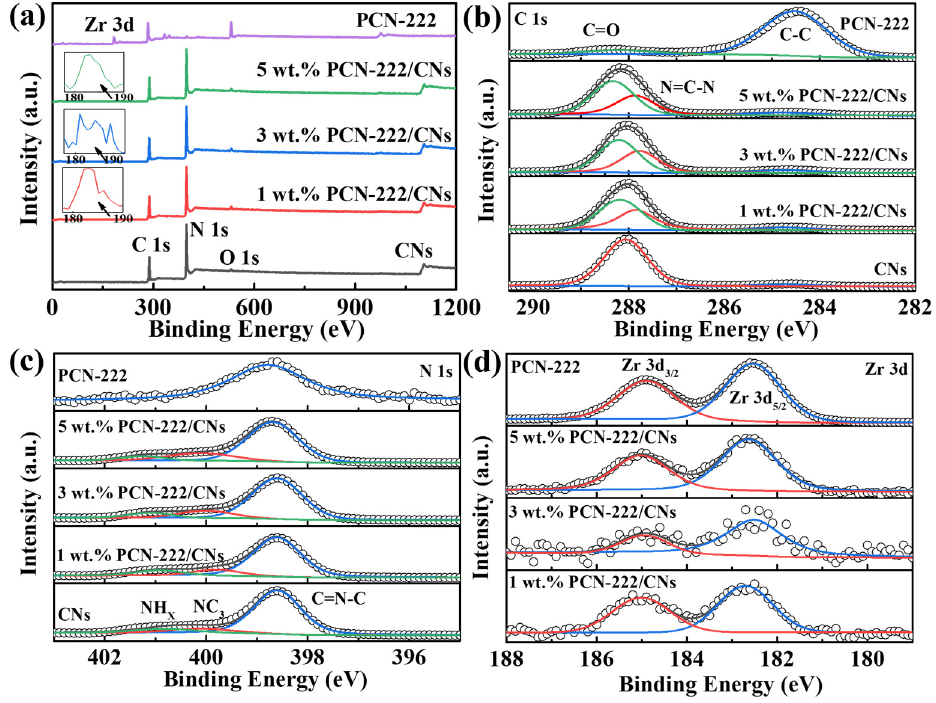
Figure 3. XPS spectra of PCN-222, CNs and PCN-222/CNs. ( a ) Survey, ( b ) C 1s, ( c ) N 1s, ( d ) Zr 3d.